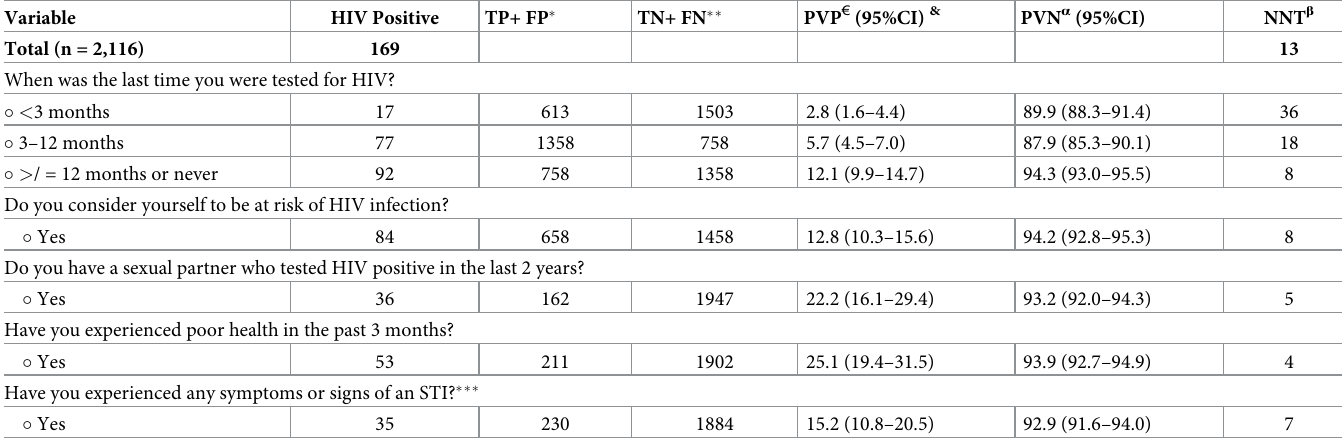
Table 5. Predictive value positive and predictive value negative for HIV testing services screening questions, Zimbabwe, 2021. (N = 2116) # .